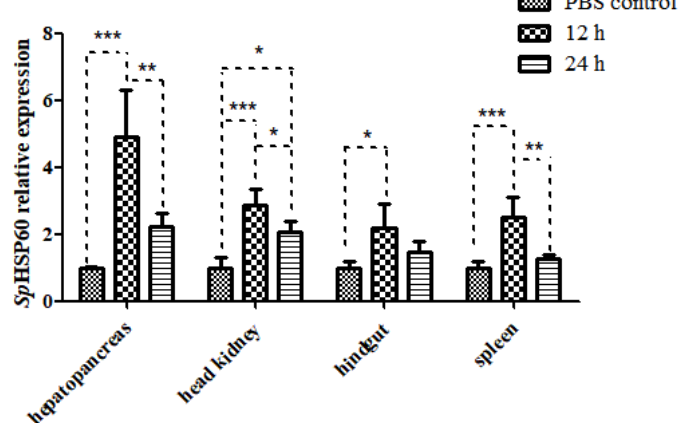
Figure 7. Transcript levels of Sp HSP60 in various tissues and at two time points after LPS challenge. Each value represents a mean ± SD ( n = 4 fish per group); statistical significance was decided using one-way ANOVA followed by Tukey tests. Note: an asterisk (*) over a column represents a statistically significant difference, one for p < 0.05, two for <0.01 and three for <0.001. n =